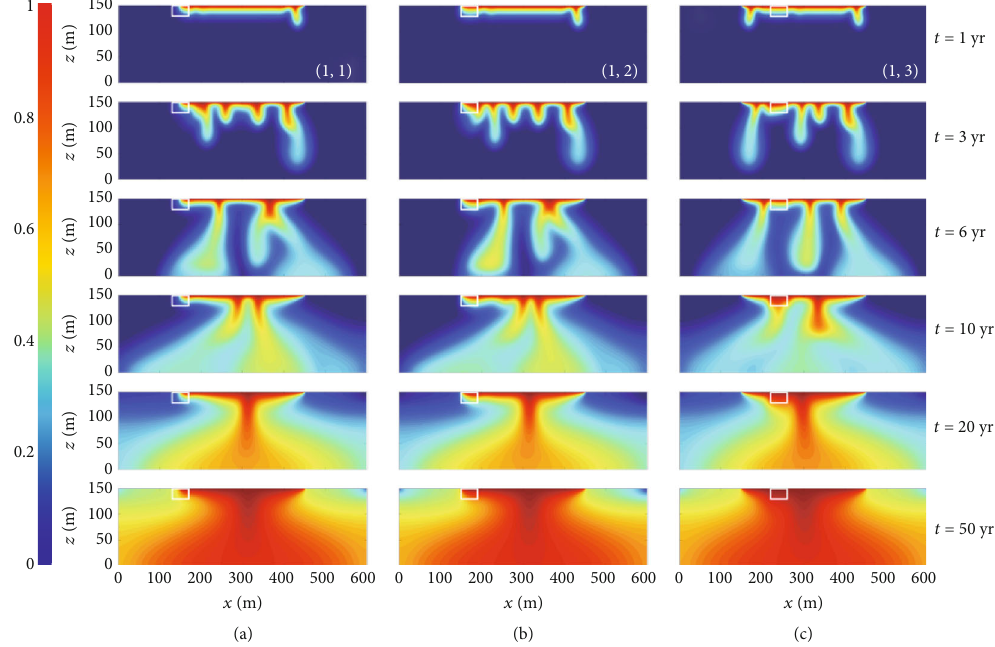
Figure 5: Concentration distributions in the domain with the low-permeability region ( k di ff erent times. The low-permeability regions are marked by the white